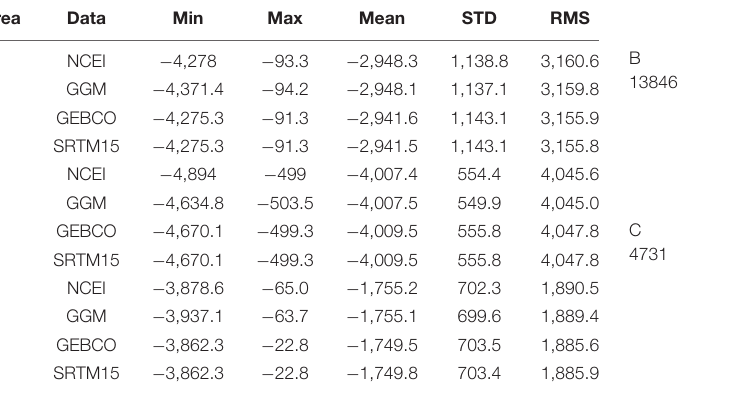
TABLE 1 | Statistics of NCEI ship-borne bathymetry, the GGM bathymetry, GEBCO model, and SRTM15 model in the test areas (unit: m). Area